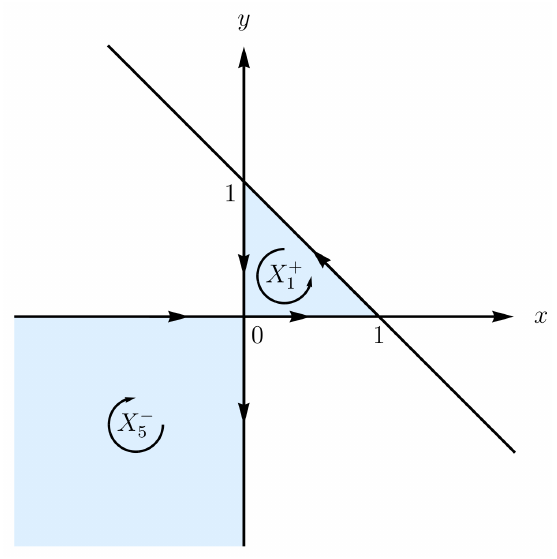
Figure 2 . Example of an oriented sum of positive geometries which is a positive